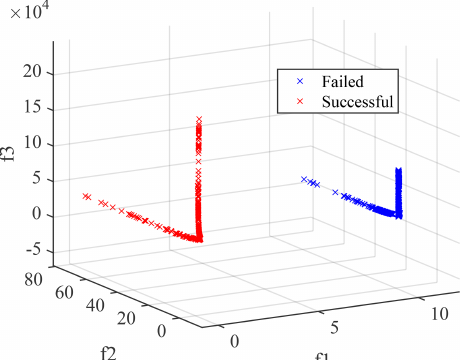
Figure 8. The minimum distances between center of obstacle and manipulator’s